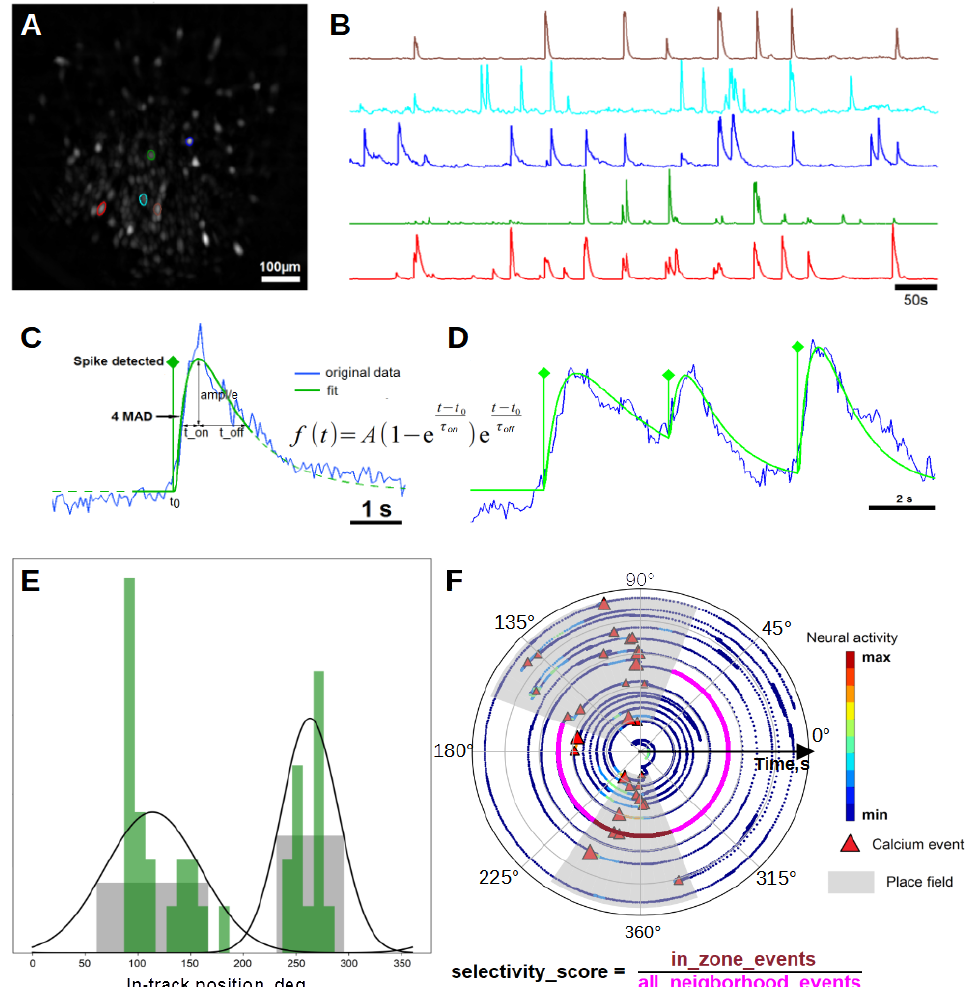
Figure 2. ( A , B ) Selected neuron locations ( A ) and their traces ( B ) extracted by MIN1PIPE routine. ( C ) Scheme of spike detection. Whenever the trace reaches the threshold value, the fitting procedure starts in a range, denoted by the solid green line. Fitting curve f(t) is set to a composition of rise and decay exponential factors and spiking amplitude A , where t 0 , t on and t off are fitting parameters. ( D ) Scheme of multiple spike detection. In case of tolerable goodness of fit (not less than 0.8), the event is scored, and the fitting curve is subtracted from the original trace, allowing next peaks to be scored. ( E ) Spatial event distribution for putative place field detection. Solid black line denotes Gaussian mixture fit of the distribution and grey zones are putative place fields. ( F ) An example of a detected place field based on the distribution on the left. Trajectory of the mouse is unfolded in the axial direction for better readability and colored with respect to raw activity of the